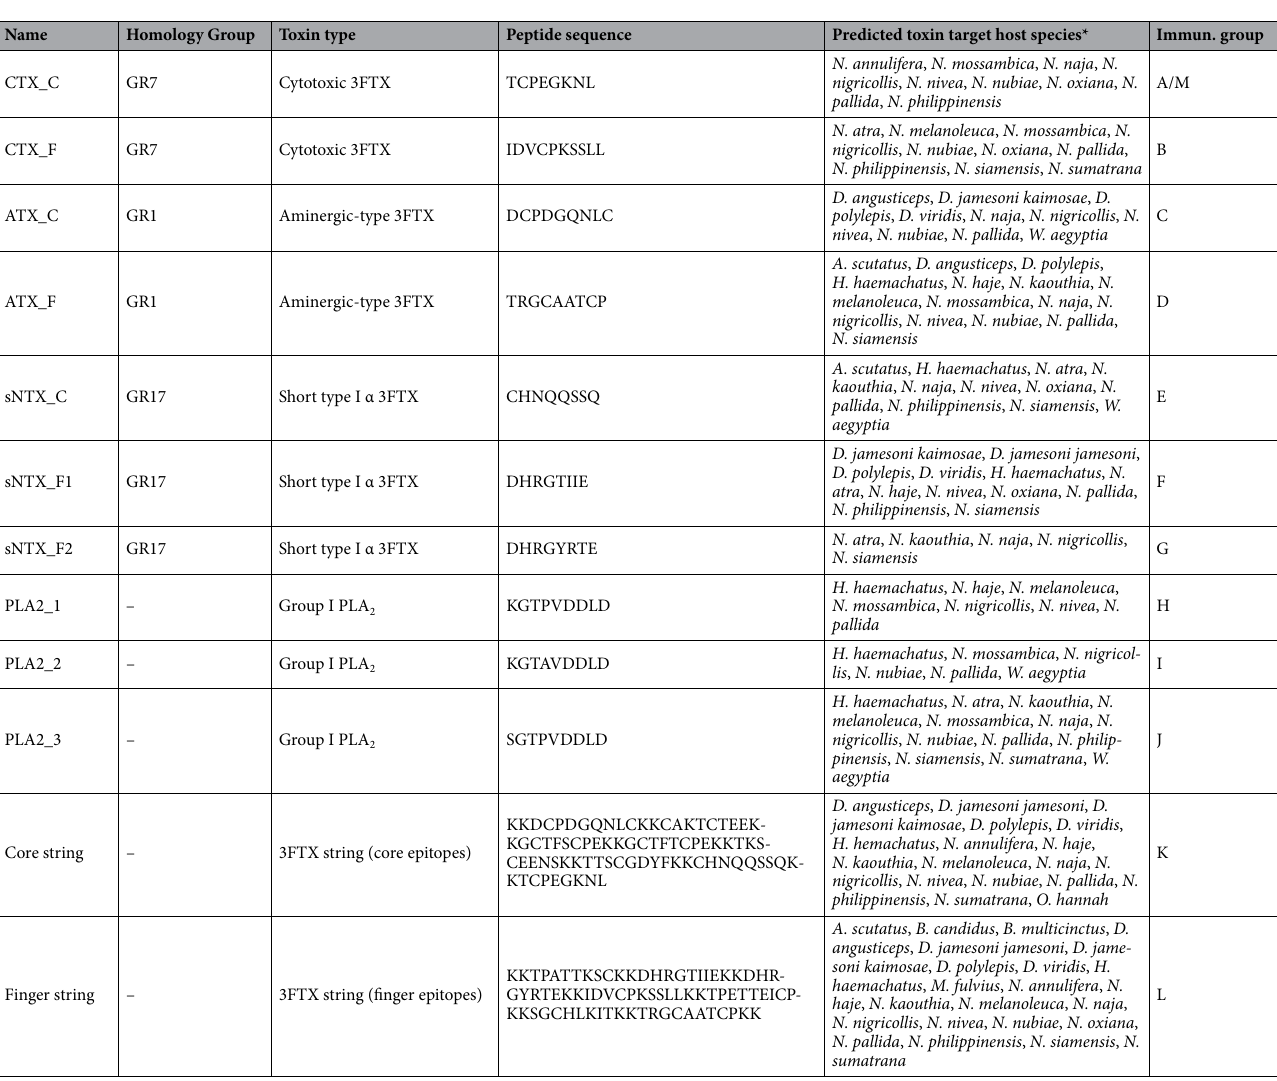
Table 1. Epitopes selected for immunisation. * = species with 100% amino acid toxin-epitope